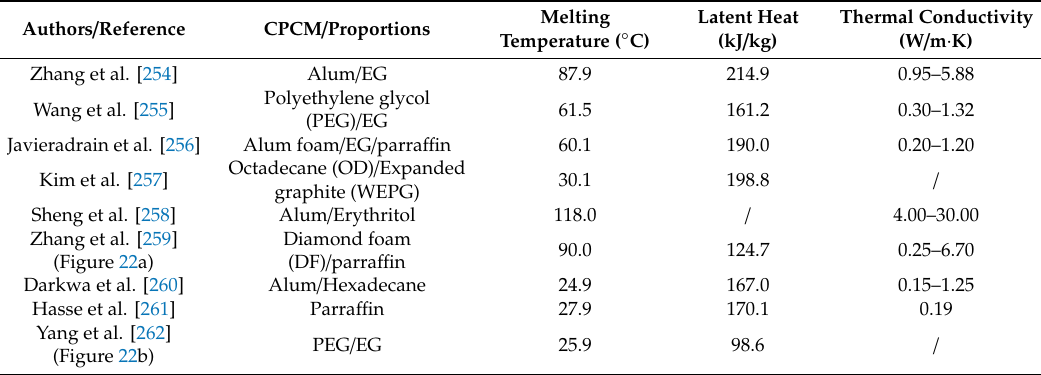
Table 3. Research cases to enhance the thermal conductivity of phase change